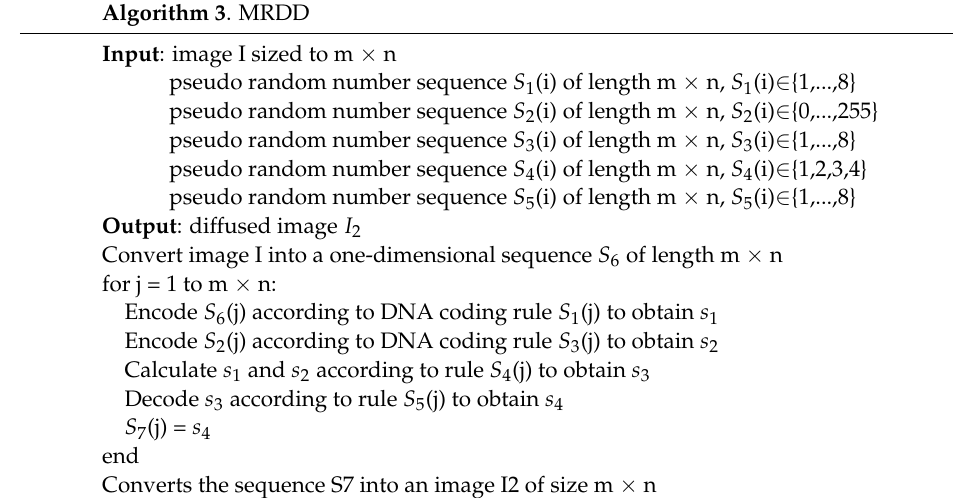
Figure 7. Encryption and decryption of grayscale images. ( a – g ) are all kinds of plaintext images, ( h – n ) are corresponding encrypted images, ( o – u ) are corresponding decrypted images. 4.2. Security and Performance Analysis In this section, the key sensitivity, histogram, correlation, NPCR, UACI, x (cid:2870) , and in- formation entropy of the proposed encryption algorithm are analyzed to test its ability to resist various attacks. 4.2.1. Key Security Analysis The key sensitivity of the encryption algorithm is verified by changing the 10 (cid:2879)(cid:2869)(cid:2873) th bit of one of the keys in the encryption and decryption processes, respectively. As shown in Figure 8, the initial encryption key used in image (b) is 1.130070465686275, and the in- itial encryption key used in image (c) is 1.130070465686276. The image d is obtained by